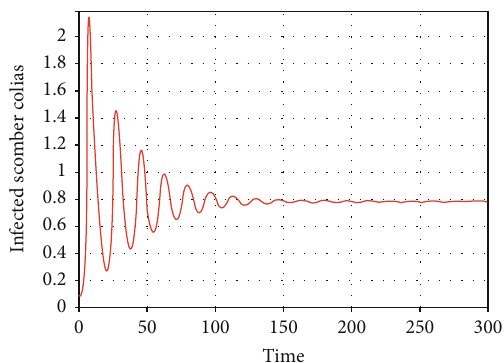
Figure 4: Dynamical behavior of the infected Scomber colias.